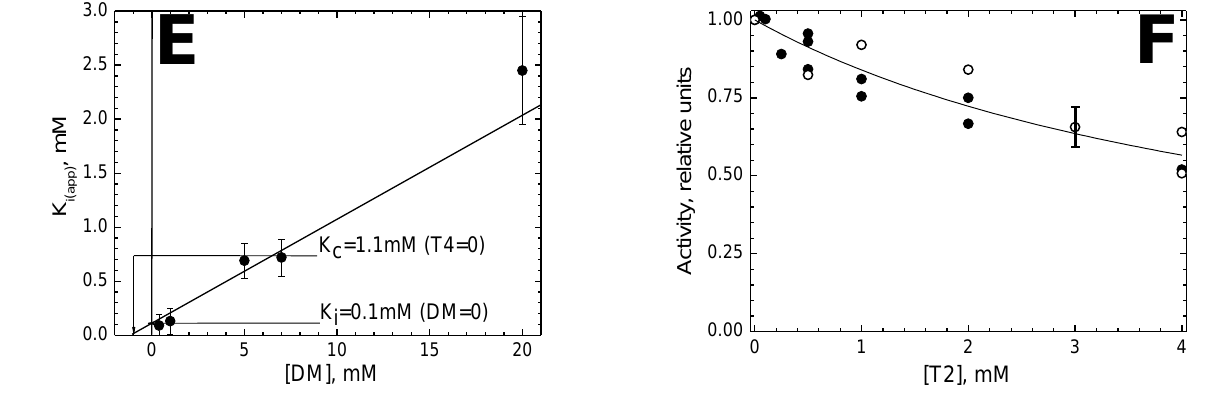
Figure 1. Inhibition of the solubilized cytochrome c oxidase (CcO) activity by thyroid hormones. ( A ) Inhibition of oxygen consumption. Additions of CcO (20 nM), cytochrome c and T4 (0.25 mM) are shown by the arrows. The kinetics trace is corrected for ascorbate autooxidation. To highlight the inhibitory effect, the trace in the absence of T4 is shown by the dotted line. ( B ) Titration of CcO activity by T3 at 0.02% dodecyl-maltoside (DM). Other conditions are mainly as in panel ( A ). Experimental data (circles) are approximated by function (1), see Section 2. The activity (the ratio of the reaction rate after the onset of inhibition to the initial reaction rate) is given in relative units. To streamline the figure, a typical measurement error is shown for only one of the experimental points (hereinafter, in similar cases). ( C ) Dependence of an apparent K i for T3 on the DM concentration. The K i(app) values are determined from the approximation of the experimental data by function (1), see panel ( B ). The segment being cut off on the Y-axis indicates the true inhibition constant K i for T3 in the absence of DM; the segment being cut off on the X-axis in its negative area indicates the value of the dissociation constant for DM in the absence of T3, K c (both segments are pointed out by arrows). ( D ) Titration of CcO activity by T4 at 0.05% DM. See panel ( B ) for further details. ( E ) Dependence of an apparent K i for T4 on the DM concentration. The K i(app) values are determined as described above, see panel ( C ). ( F ) Titration of CcO activity by T2 at 0.05% (filled signs) and 1% (open signs) DM. Other conditions are mainly as in panel ( A ). The entire dataset is approximated by function (1).